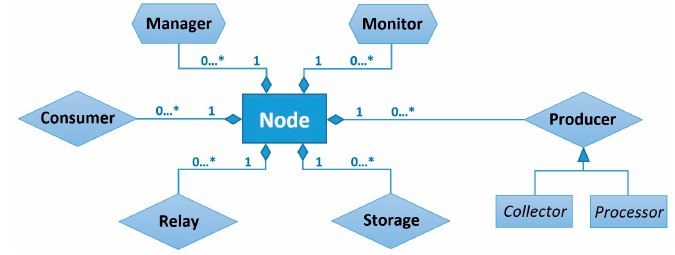
Figure 3. Structure of a MASU node.